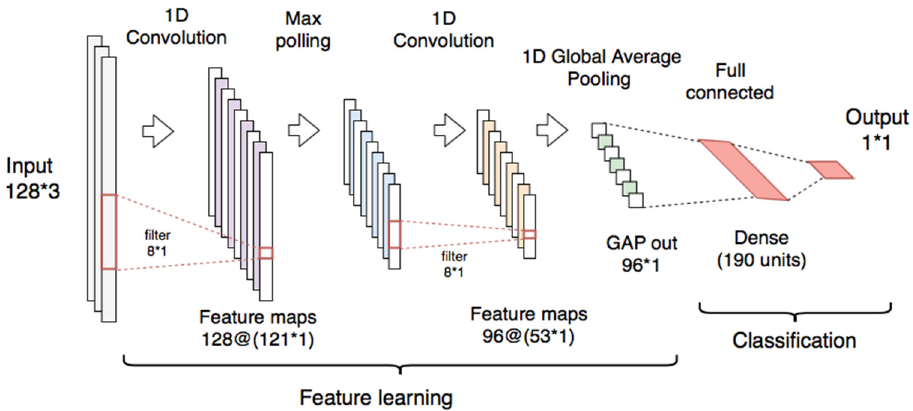
Figure 6. Convolutional neural network used for the context classifier using the raw signals.